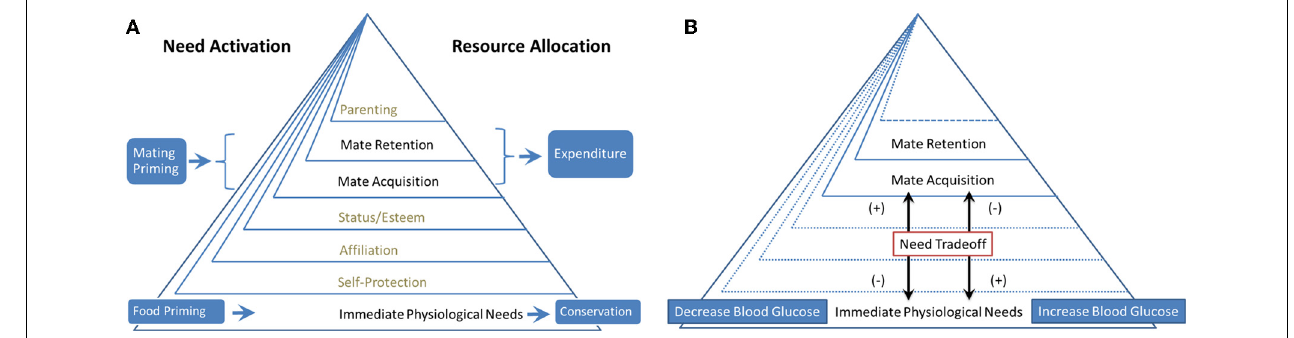
FIGURE 1 | (A) Experiment 1. The effect of need activation on resource allocation; (B) Experiment 2. Regulating the cognitive priority of different